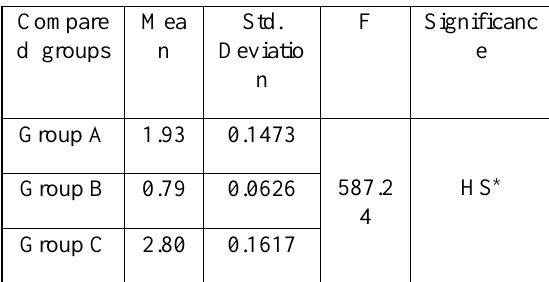
Table 3: ANOVA test comparison among groups. Group A Evetric composite resin, group B Estelite Sigma Quick composite resin,and group C G-aenial composite resin